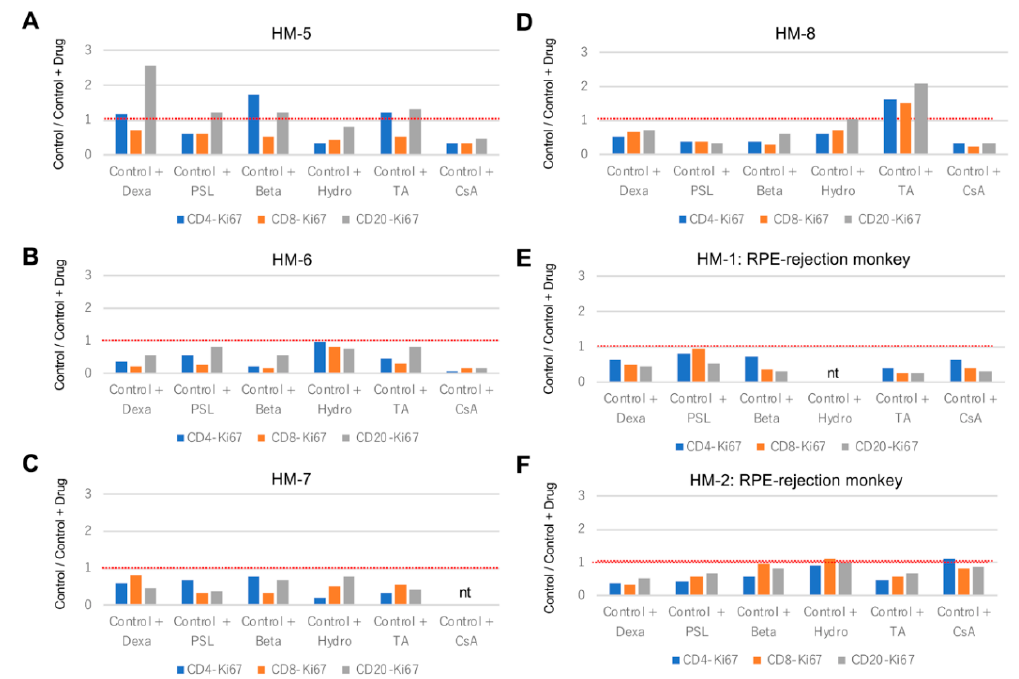
Figure 4. Summary of Drug-LGIR assay in monkeys. ( A – F ) The results of Drug-LGIR assay with dexamethasone (Dexa), prednisolone (PSL), betamethasone (Beta), hydrocortisone (Hydro), triamcinolone (TA), and cyclosporine A (CsA) in PBMC from six monkeys: HM-5 ( A ), HM-6 ( B ), HM-7 ( C ), and HM-8 ( D ) that were not transplanted ( n = 4) and HM-1 ( E ) and HM-2 ( F ) that showed RPE-rejection after transplantation ( n = 2). The rate of proliferative immune cells indicated by expression of Ki-67 by FACS are shown in bar graphs to evaluate the suppressive effect of each drug. Red dotted-lines indicate the baseline (Control = 1.0, PBMC + iPS-RPE cells without drug). nt: not tested.